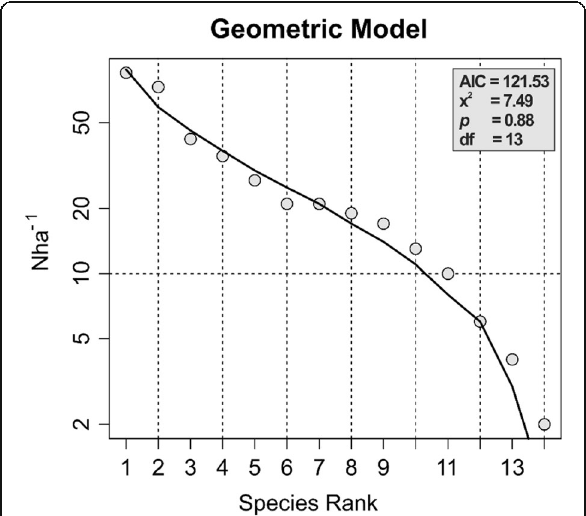
Fig. 3 Range of species abundance in the study area, where: N/ha = Number of trees per hectare, AIC = Akaike ’ s Information Criterion, χ 2 = Chi-square test, df = degree of freedom test χ 2 , p =